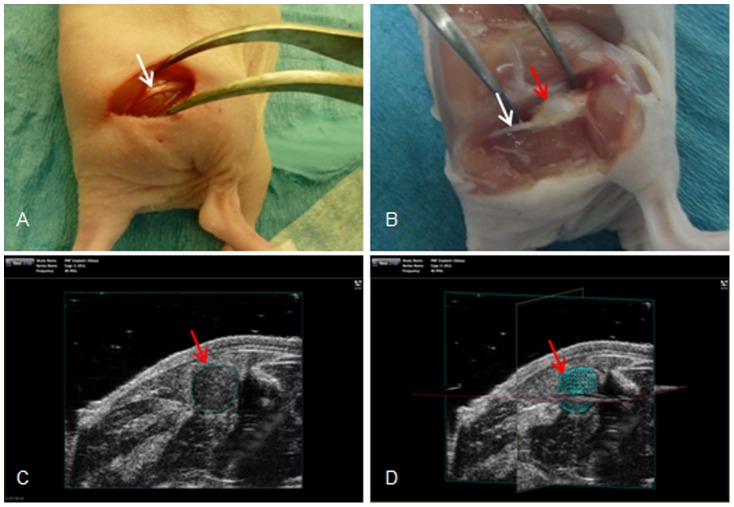
Xenograft on sciatic nerve in mouse.(A) The exposed sciatic nerve (white arrow) for implantation, (B) a PNF xenograft (red arrow) integrated onto the sciatic nerve, (C) images and (D) three-dimensional reconstruction of a xenograft by (red arrow) a Vevo 2100 micro-imaging system.